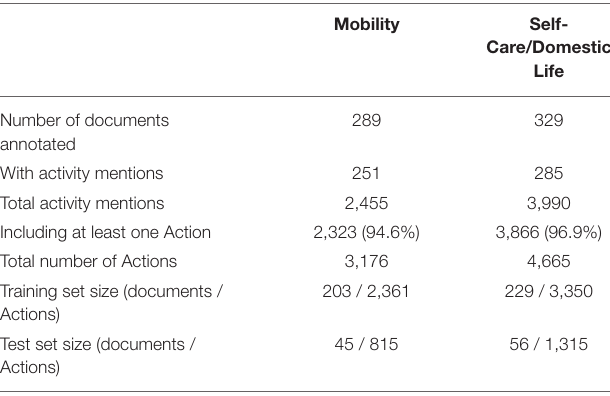
TABLE 2 | Datasets of documents annotated for functional status information, drawn from U.S. Social Security Administration disability benefits cases.